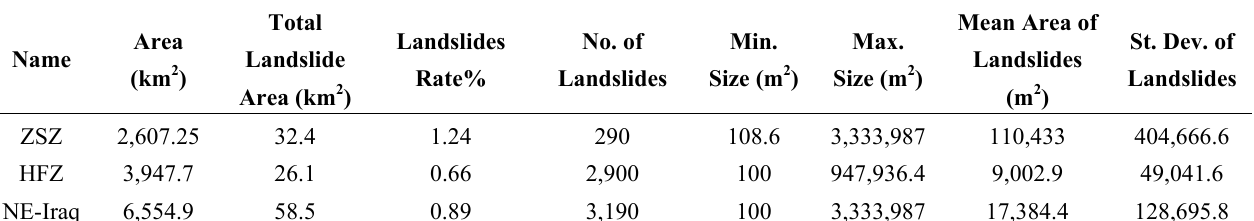
Table 1. Statistical characteristics of the landslides (rotational landslide, flow, rock fall and